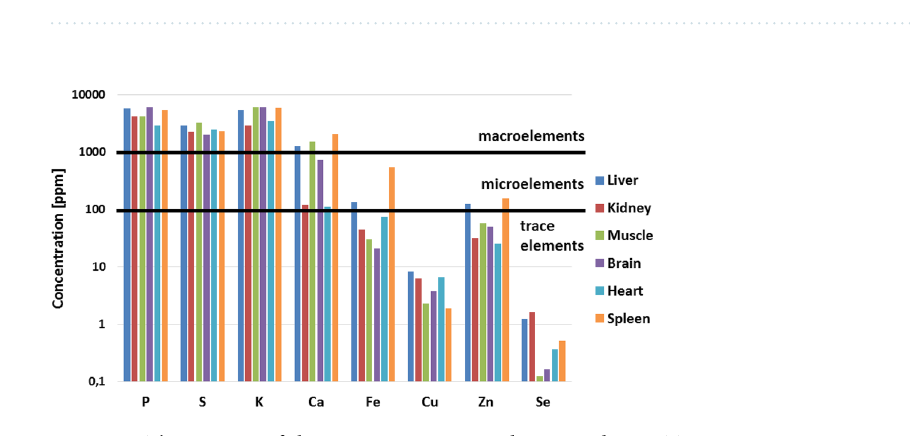
Figure 6. An example of X-ray fluorescence spectrum registered for liver sample. Kα, Kβ and L spectral lines were marked with black, green and purple colours, respectively. Lines of the analysed elements were marked with red arrows.